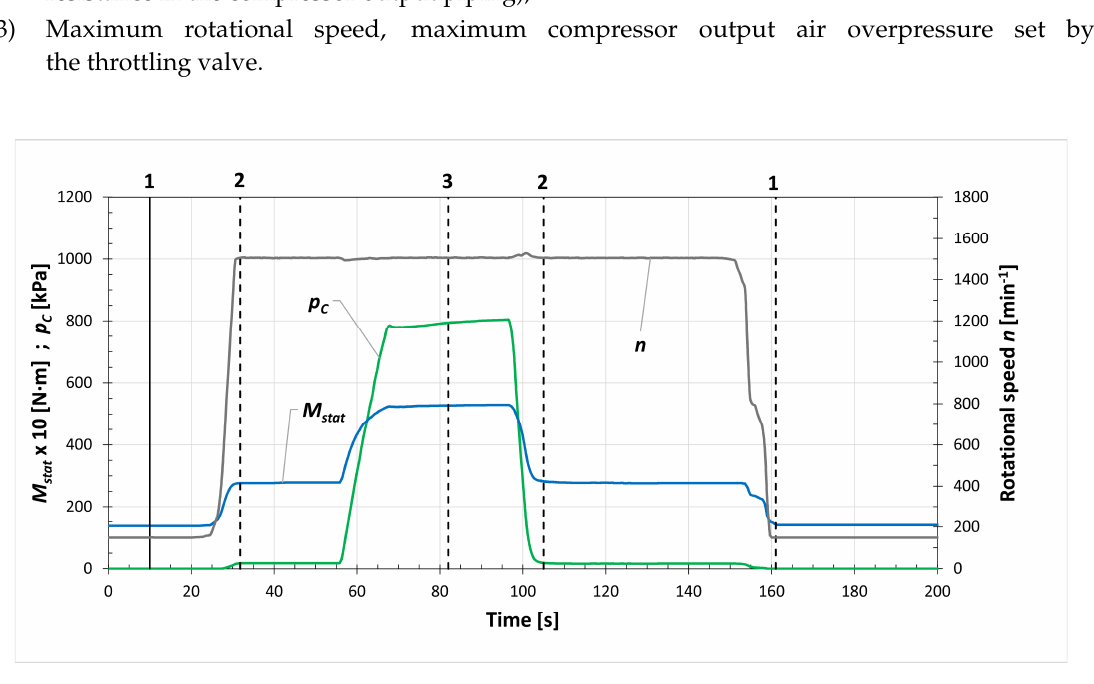
Figure 8. Operating modes of the mechanical system used during